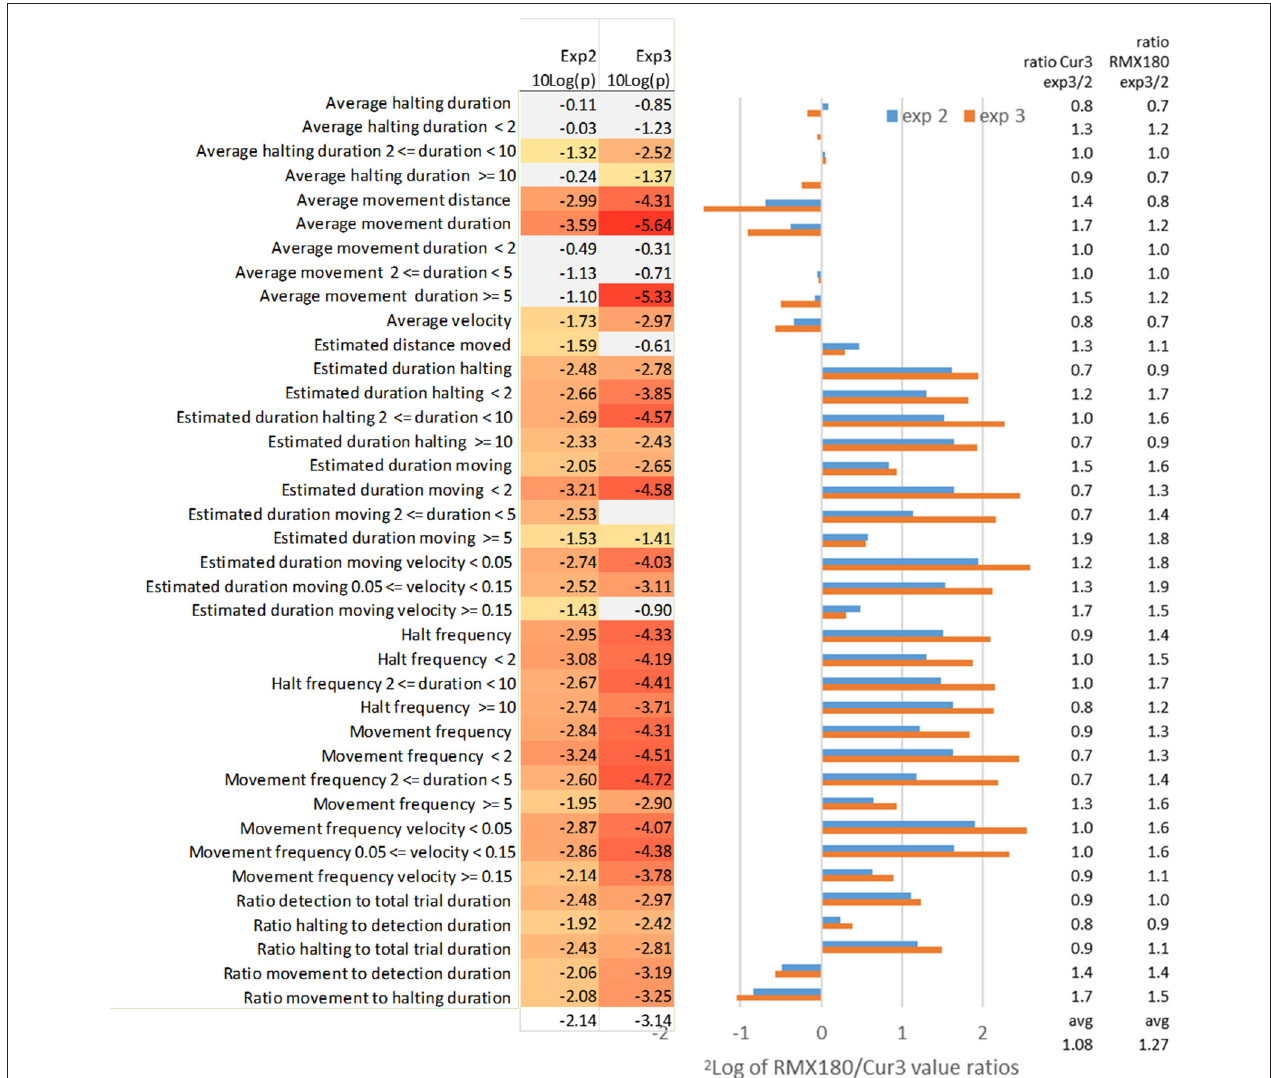
FIGURE 3 | Effect of independent experimental replication (experiments 2 and 3) on the log2 of RMX180/Cur3 value ratios and the value ratios across experiments per genotype and on the significance of the statistics ( N = 39–40). Marked in red are significant [log 10 ( p ) < − 1.3 ∼ p < 0.05], marked gray are not significant [log 10 ( p ) > − 1.3 ∼ p > 0.05]; the settings of analysis F3 ( Tables 1 , 2 ) were used to compare both